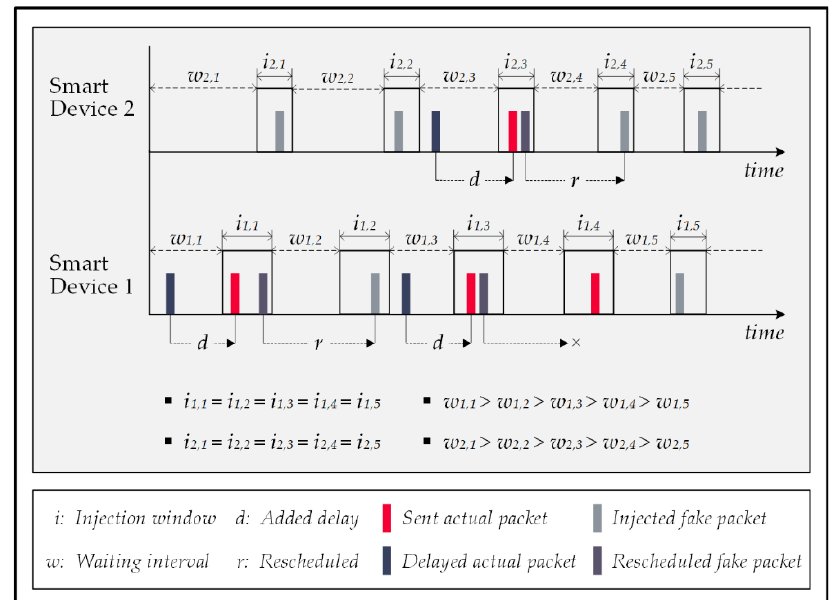
Figure 12. The FitProbRate scheme.